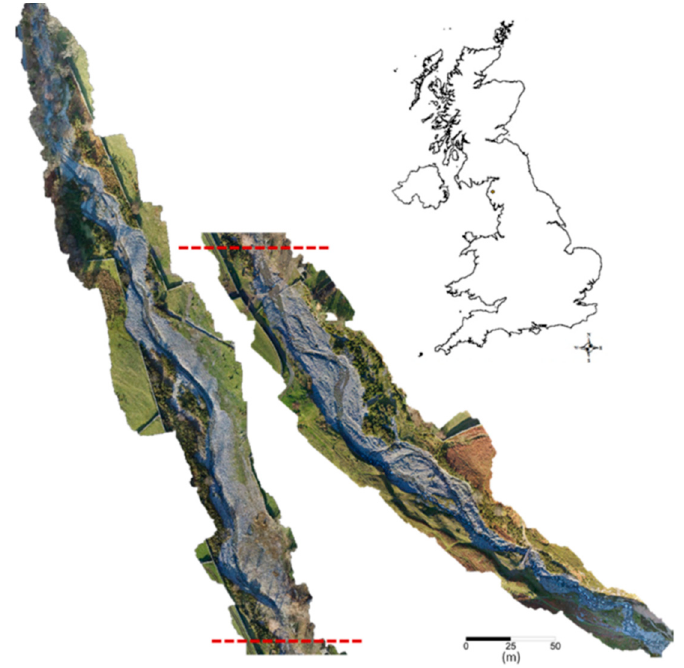
◦ , Longitude − 3.298623 ◦